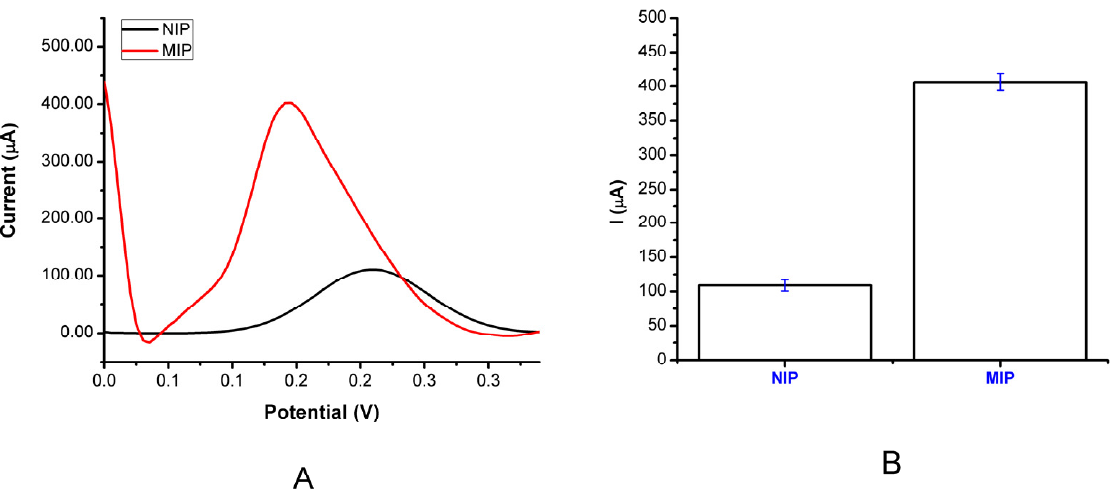
Figure 5. Modified electrode responses; ( A ) MIP PGE and NIP PGE sensor responses for the DA molecule; ( B ) Error bars for the MIP PGE and NIP PGE sensor responses ( n = 3).